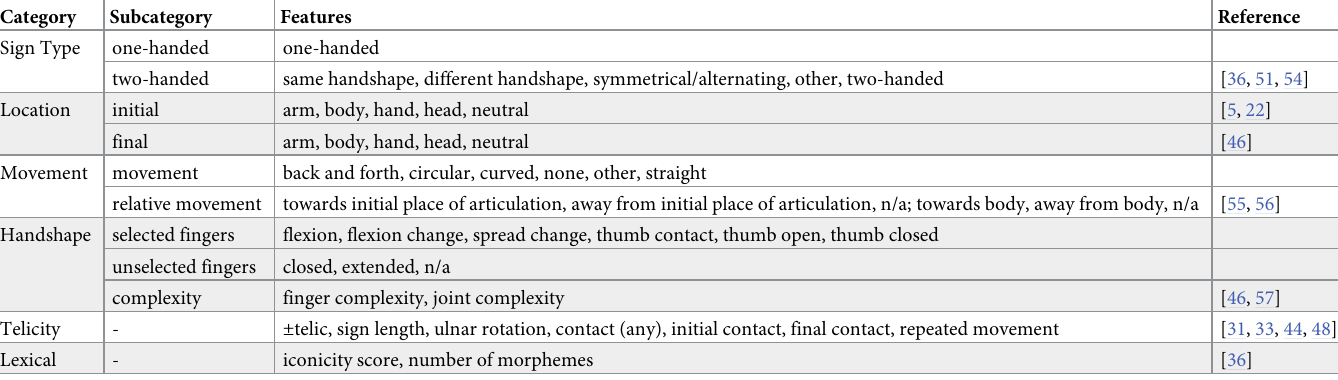
Table 2. List of candidate features potentially relevant to transitivity